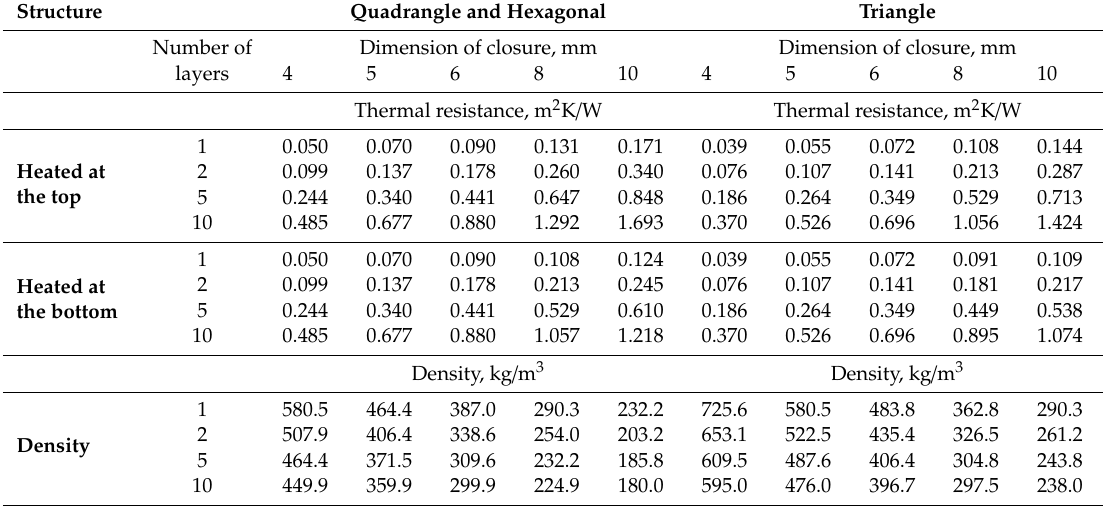
Table 2. Thermal conductivities and densities calculated for di ff erent